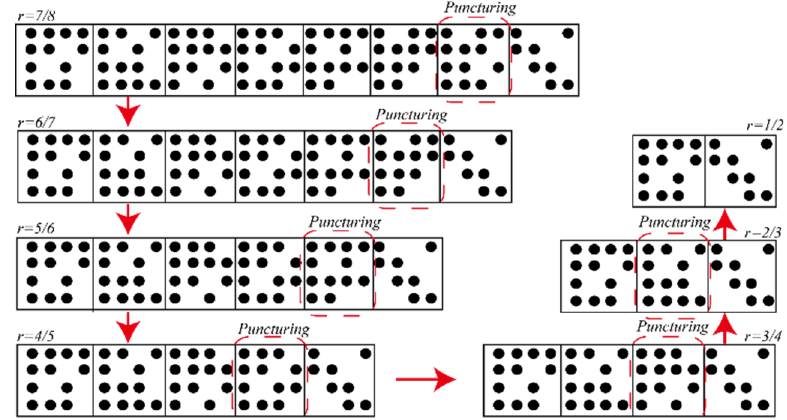
Table 3. Parameters of the designed RC-NB-LDPC codes.